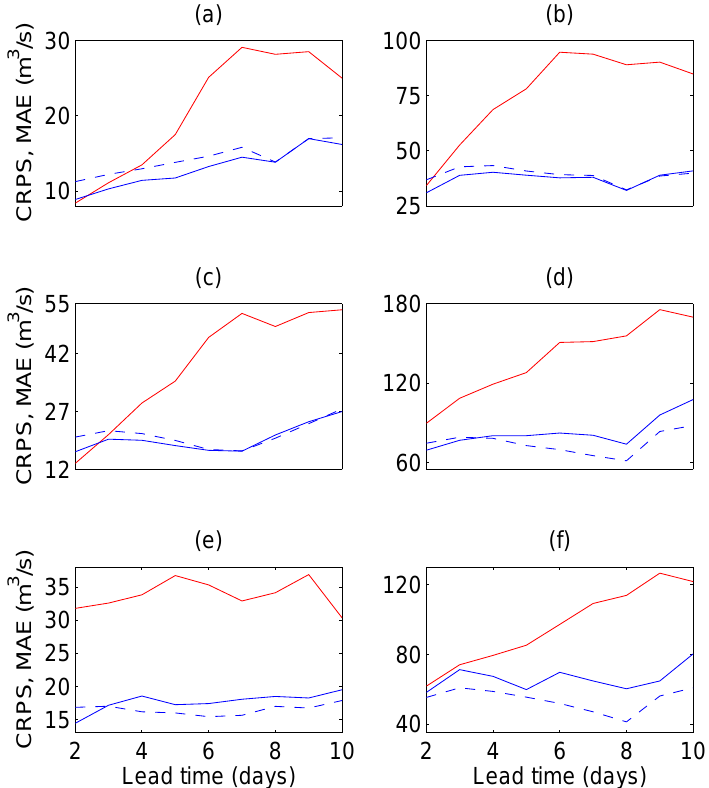
Fig. 10. Comparison between high resolution deterministic forecasts (red line) and low resolution post-processed (blue solid line) and raw (dashed blue line) ensemble forecasts in terms of CRPS and MAE (a) Chelsea (b) Paugan (c) Maniwaki (d) Baskatong (e) Cabonga (f)